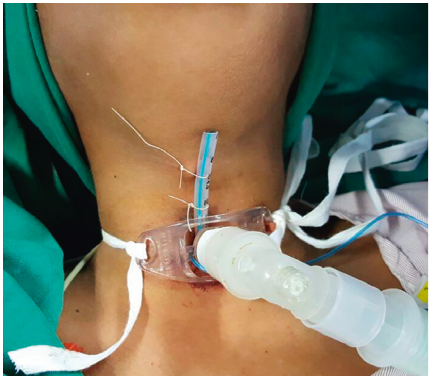
Figure 5: Endotracheal tube number 4 inserted after laser-assisted release of